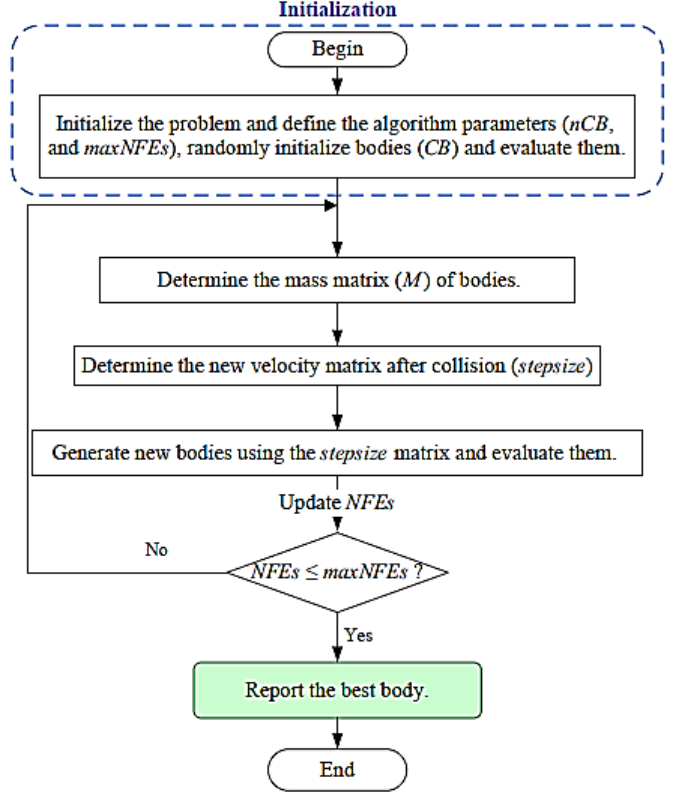
Figure 3. The structure of the colliding body (CB) algorithm (NFE: Maximum Number of Objective Function Evaluations).